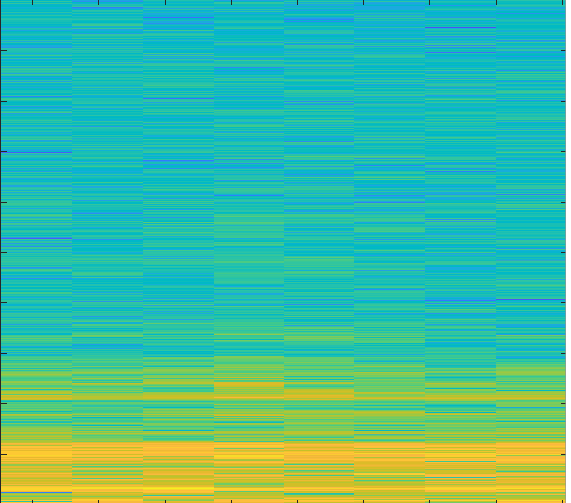
Figure 15. Softwood, Average Tool, 3 mm depth-of-cut.